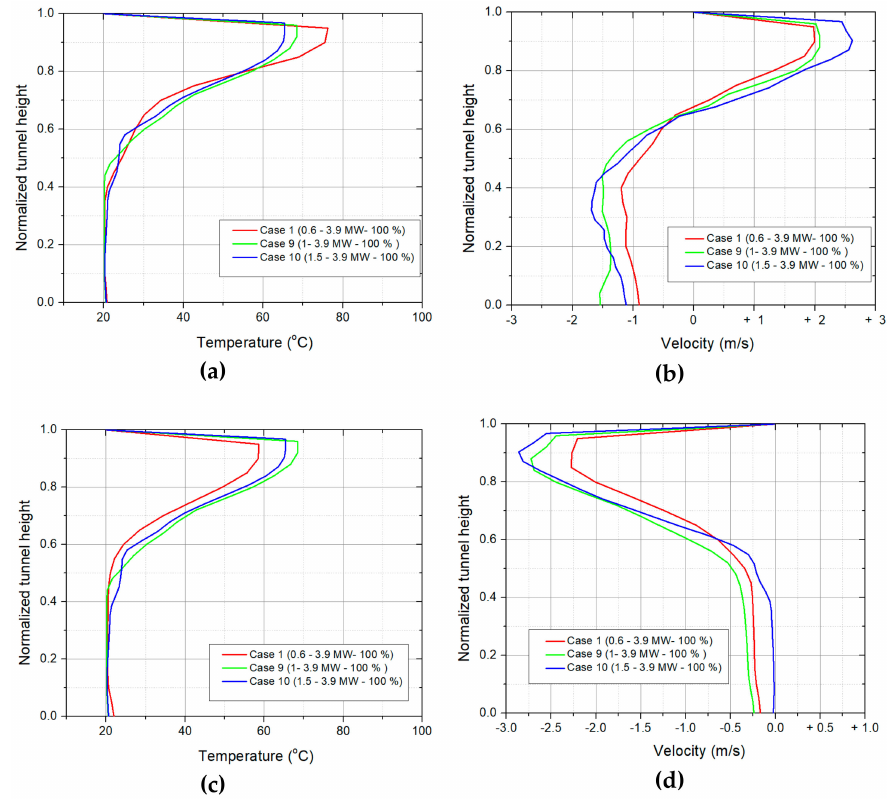
Figure 12. Temperature and velocity distribution in the tunnel: ( a ) temperature distribution at Y = 120; ( b ) velocity distribution at Y = 120; ( c ) temperature distribution at Y = 300 and ( d ) velocity distribution at Y =